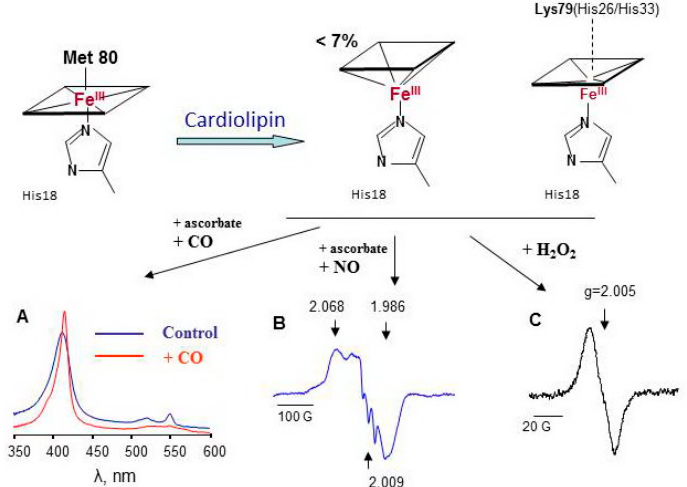
Figure 5. Cardiolipin induces protein unfolding of cyt c accompanied by the loss or exchange of the distal heme iron ligand resulting in an increased accessibility of heme for small molecules [26,75]. ( A ) absorbance spectra of native cyt c (II)/CL complexes and complexes incubated with CO; ( B ) LT EPR spectrum of nitrosylated cyt c (II)/CL complexes, ( C ) LT EPR spectrum of cyt c (III)/CL complexes exposed to H 2 O 2 for 30 s;